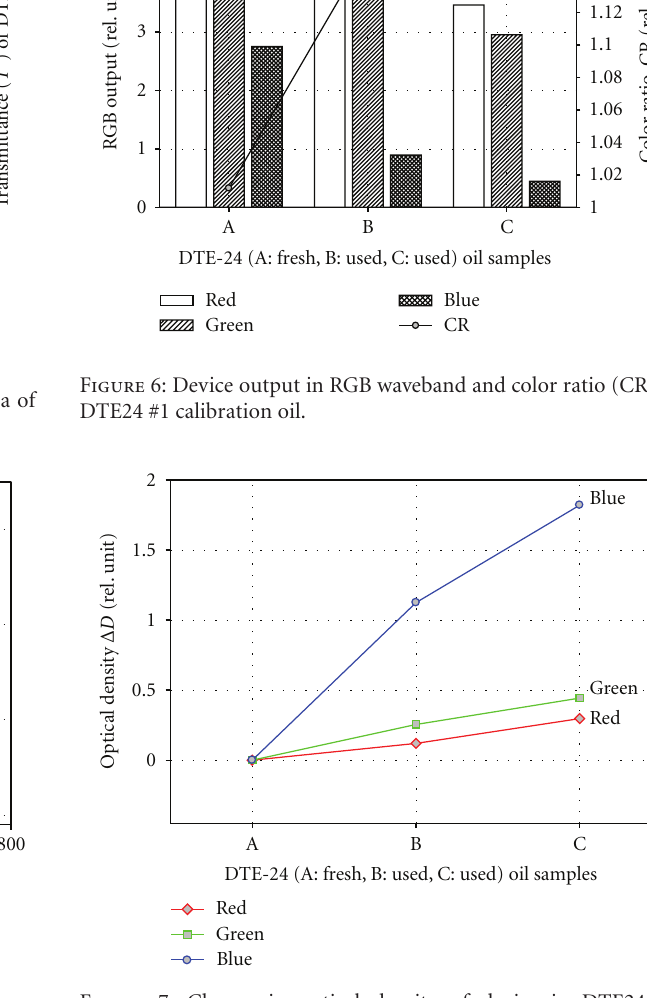
Figure 7: Change in optical density of device in DTE24 #1 calibration